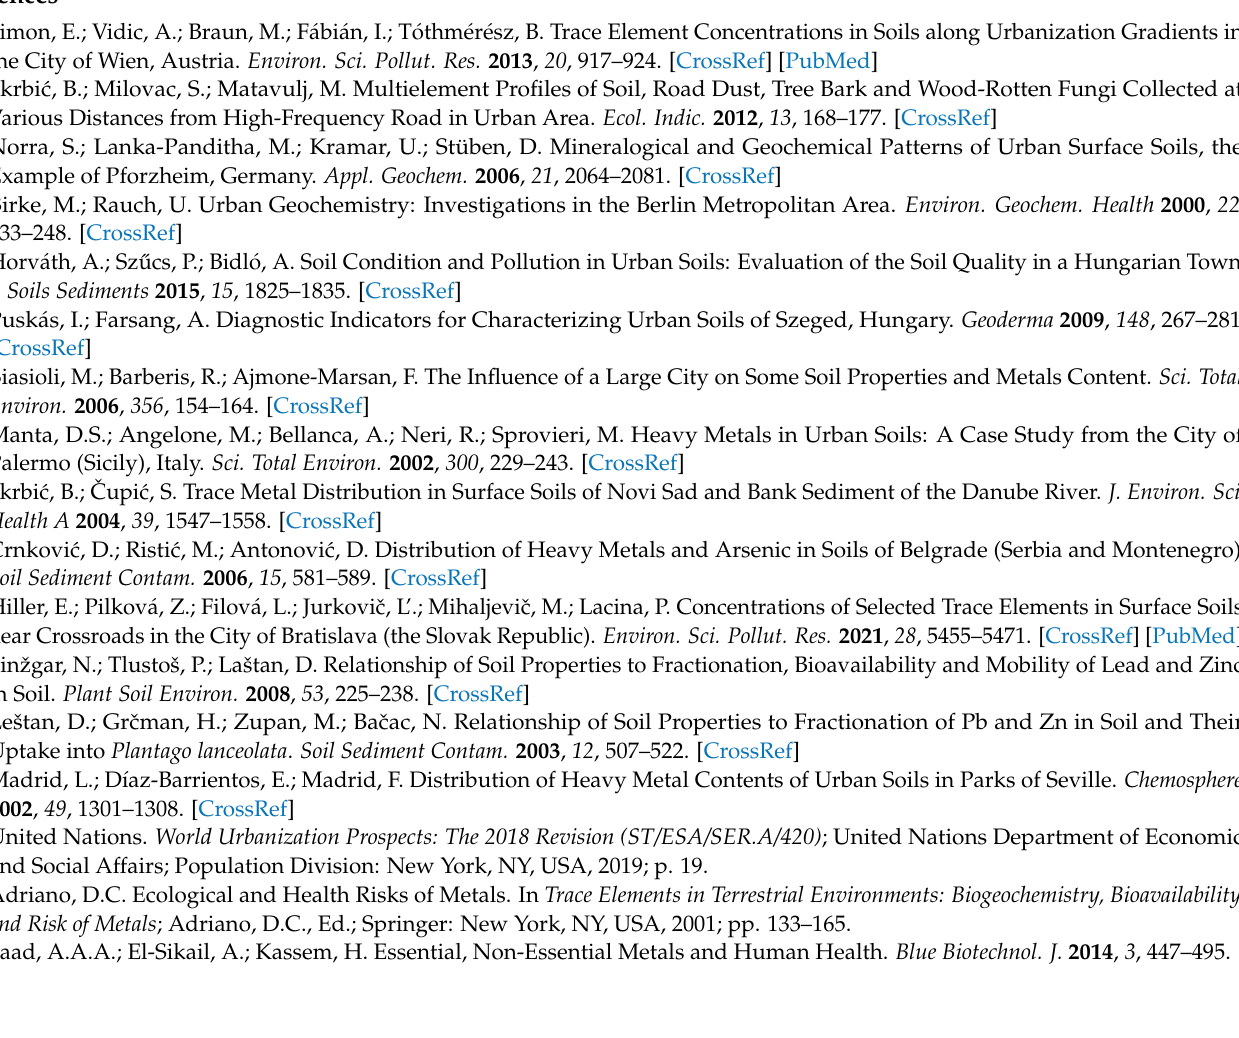
p < 0.05. Figure S1. Total monthly precipitation and precipitation per day (mm) for the period from January to July 2013. Source of data: Meteorological and Hydrological Service of Croatia, Zagreb [90]. Figure S2. Precipitation amount per hour (mm) and intensity range for the period from January